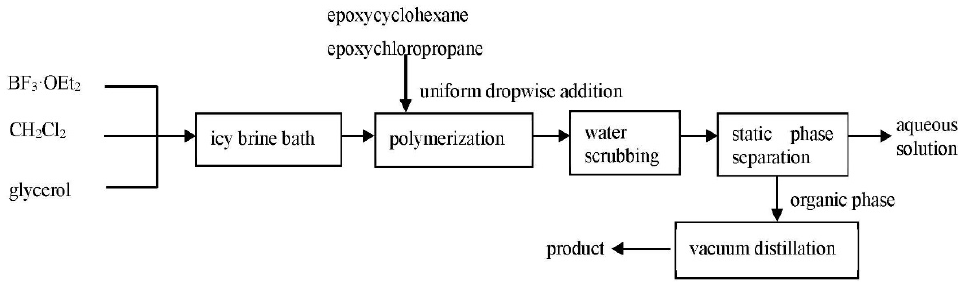
Figure 2. Synthesis process of copolyether. The IR spectrum of the copolyether is shown in Figure 3. According to the IR spectrum, the characteristic absorption peak of hydroxyl group is at 3347 cm − 1 . The strong absorption peaks at 2930 cm − 1 and 2857 cm − 1 are methylene and methine groups, respectively. The absorption peak of the aliphatic ether bond is at 1083 cm − 1 , and the peak was chosen as an iconic functional group of copolyether. The absorption peak of carbon-chlorine bond is at 780 cm − 1 .